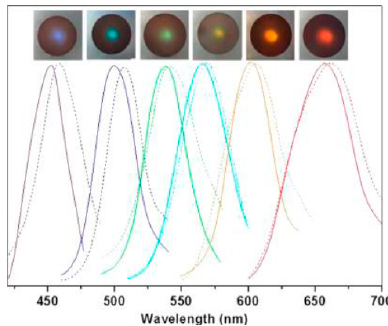
Figure 20. Reflection spectra of the various non-modified (solid lines) and porphyrin-modified (dotted lines) colloidal crystals [149]. Adapted with permission from ACS Appl. Mater. Interfaces, 4, 6752–6757. Copyright (2012) American Chemical Society.